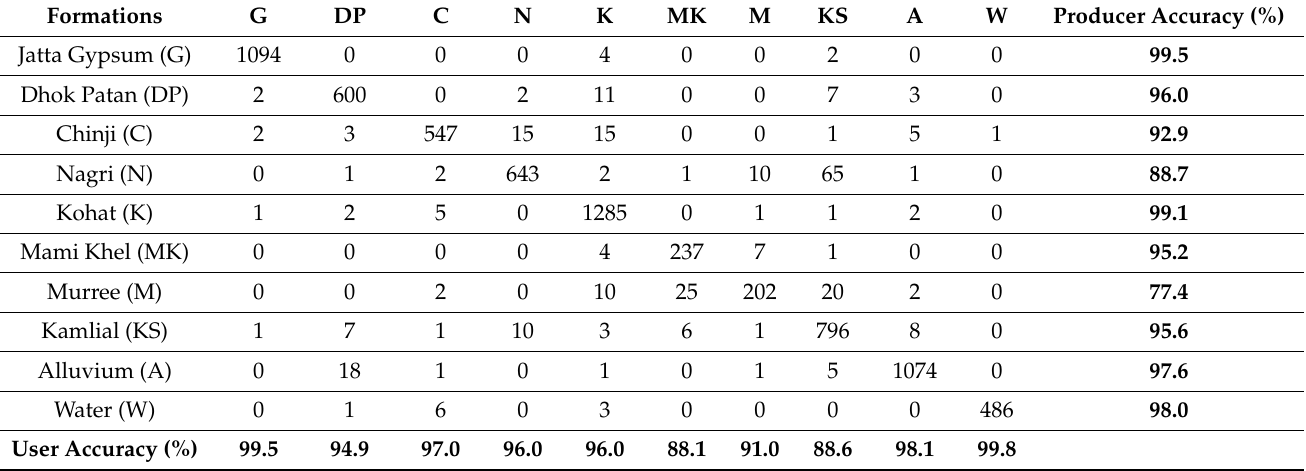
Table 4. Confusion matrix of artificial neural network (ANN) (with Adam optimizer).